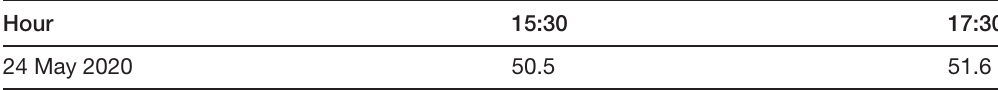
An example of a photograph overlaid with measured noise level (dBA, slow, peak) showing activities of people on the riverbanks. This photograph was taken at the same point as that of measurements shown in Table